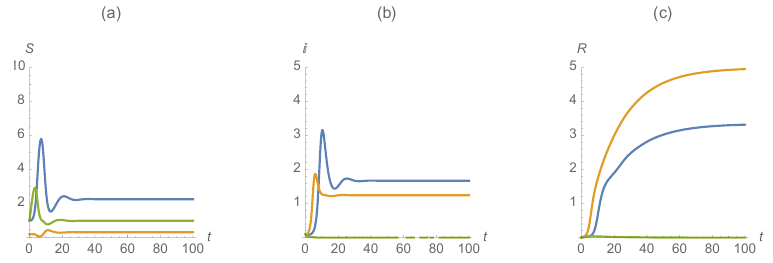
Figure 5. ( a ) S j , ( b ) I j , and ( c ) R j . The first disease is represented in blue, the second in orange and those susceptible/infected/recovered by diseases in